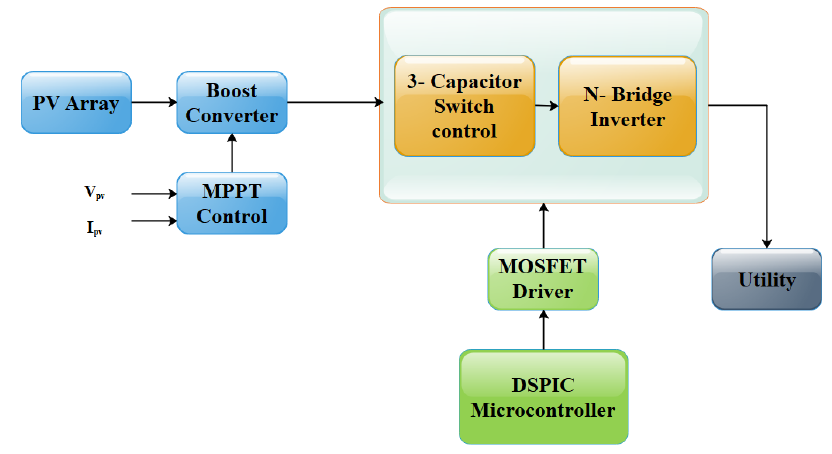
Figure 32. Block diagram for multilevel inverter circuit.